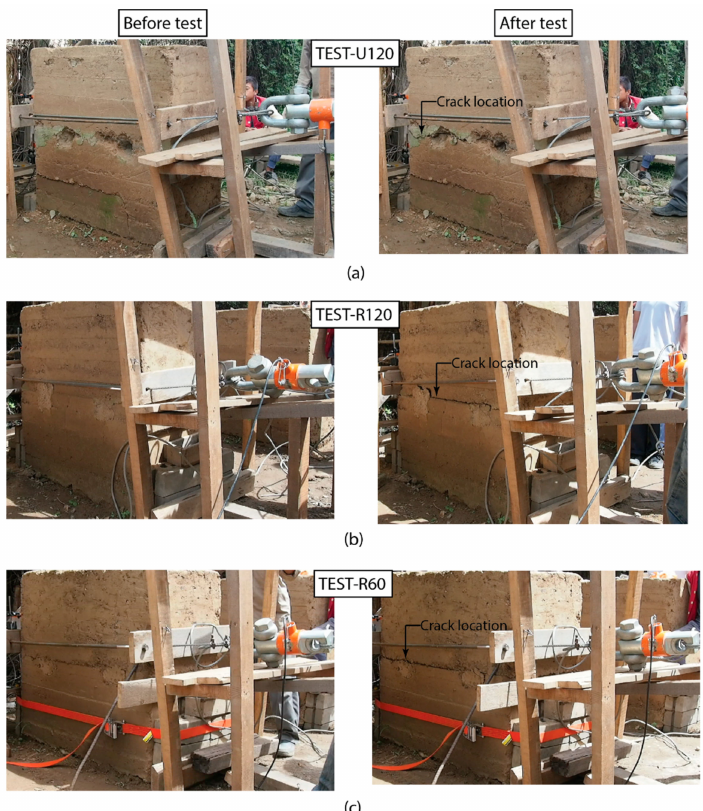
Figure 8. Crack patterns observed for: ( a ) Unreinforced RE with 120 mm layer thickness (TEST–U120); ( b ) TEST–R120; ( c )